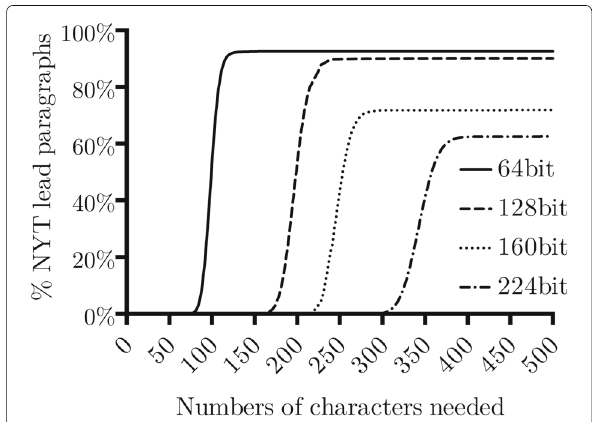
Fig. 7 Length requirements to successfully embed the watermark. Percentage of leading paragraphs in NYT Corpus that can be watermarked using only the first n characters. Results are shown for different hash lengths